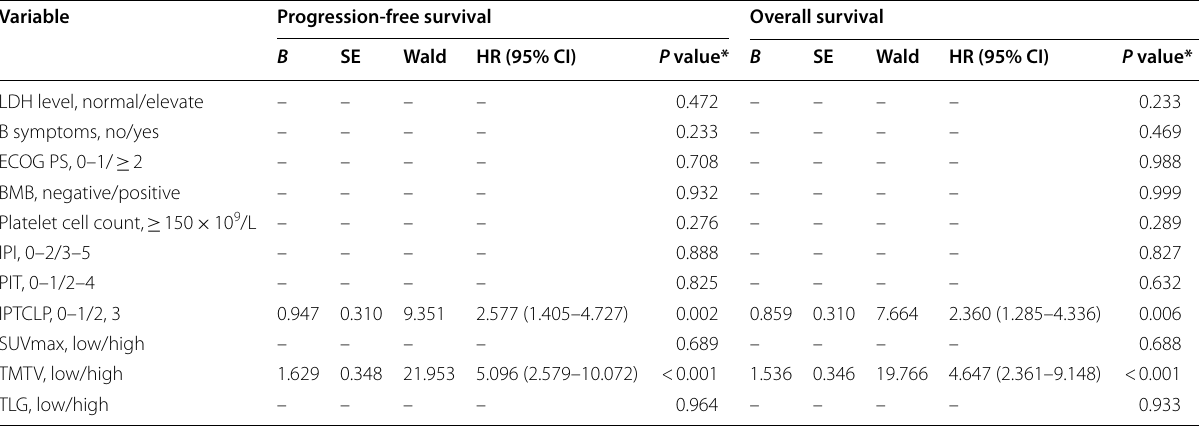
Univariate analyses of factors predictive of survival in patients whose scans were evaluated using TMTV and TLG CI confidence interval, SE standard error, CI confidence interval, HR hazards ratio, LDH lactate dehydrogenase, ECOG PS Eastern Cooperative Oncology Group performance status, BMB bone marrow biopsy, IPI International Prognostic Index, PIT prognostic index for T-cell lymphoma, IPTCLP International peripheral T cell lymphoma Project, TMTV total metabolic tumor volume, TLG total lesion glycolysis * P <